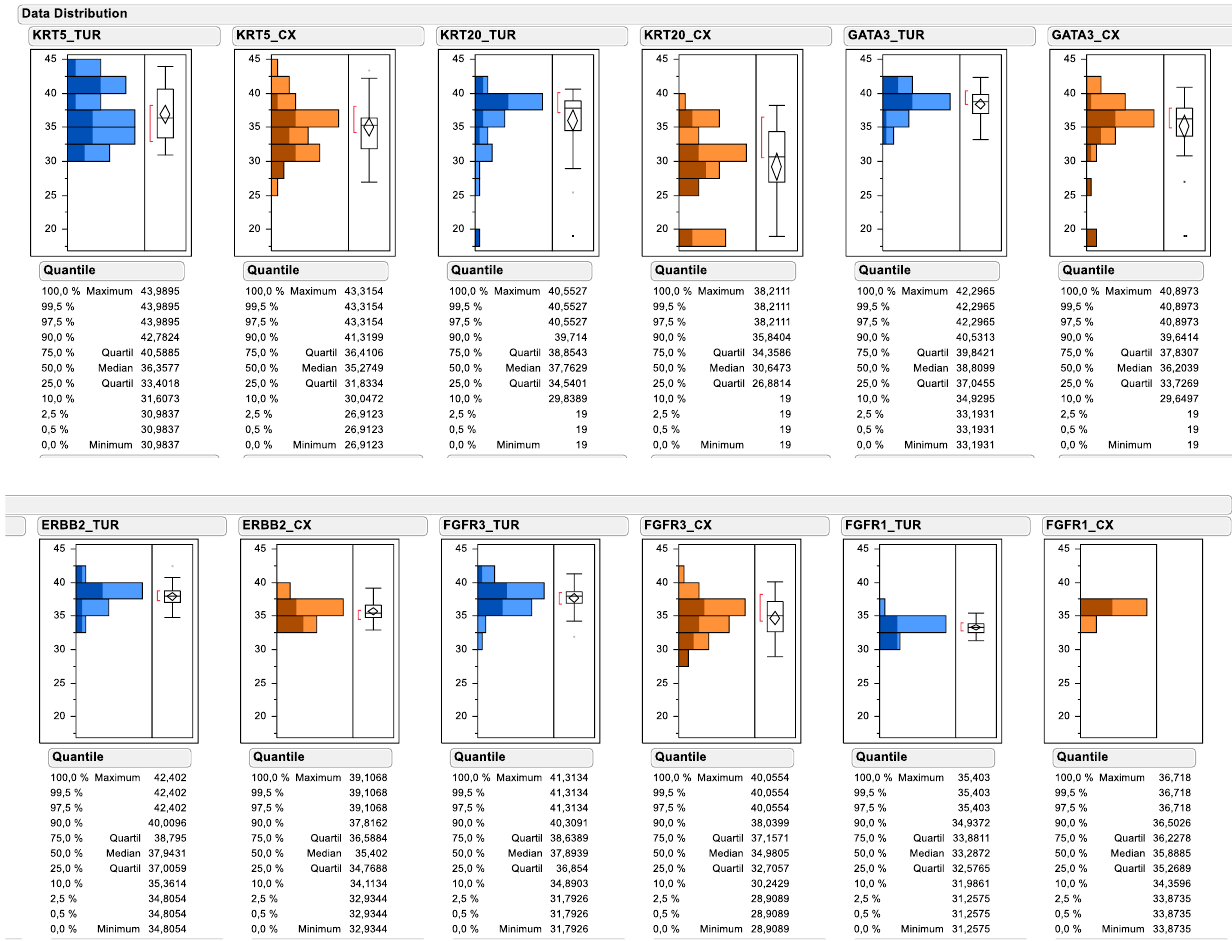
Figure 2. Data distribution of subtyping and target gene expression as determined by standardized RT-qPCR. Continuous mRNA expression levels are depicted as 40-DCT values by subtracting reference gene CT values from candidate gene CT values (=DCT). The subtraction of the DCT from the total number of the PCR reaction converts the numbers, so that higher numbers mean higher expression levels. Pretreatment mRNA expression in TUR biopsies is depicted in blue. Posttreatment mRNA expression is depicted in orange. Upper panel depicts the subtyping marker, lower panel the assessed target genes. Tumor gene expression from tumors achieving pCR are displayed by darker coloring.